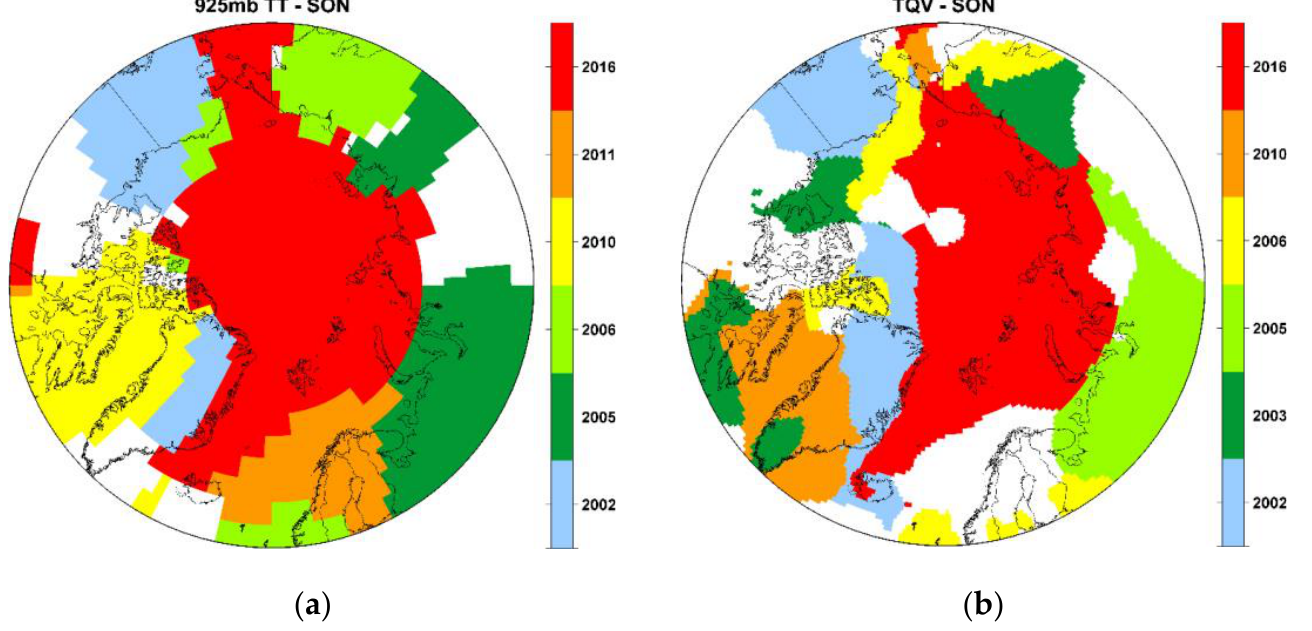
Figure 6. ( a ) The spatial extent and the year of record of the warmest autumns (925 mb TT SON); ( b ) the same as in ( a ) but for the wettest autumns (TQV SON). Analyzed period: 1982 – 2016.